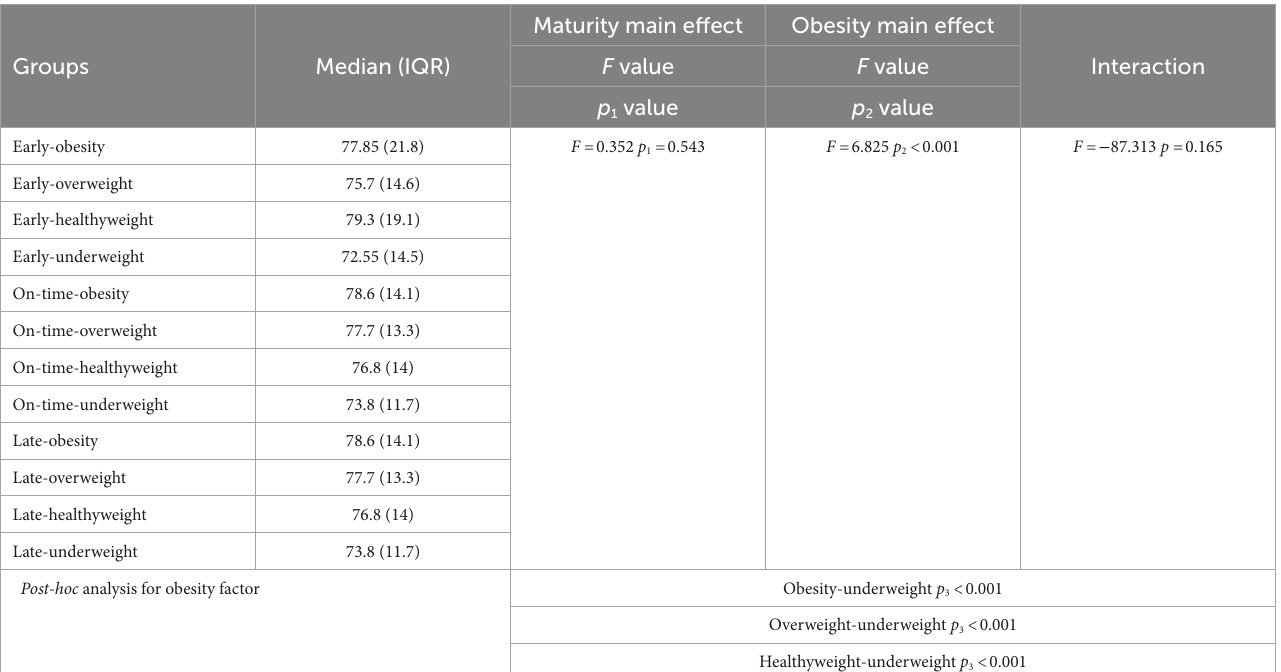
TABLE 5 Changes in the leg length of the participants according to the maturity and obesity groups.